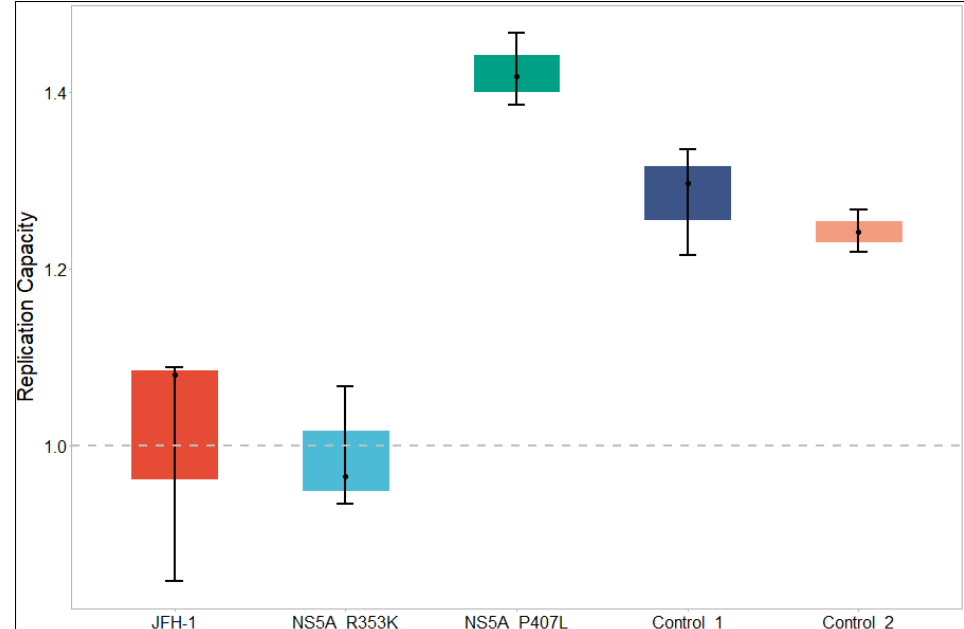
Figure 2. Replication capacities of JFH-1 (wildtype), SGR constructs harbouring polymorphisms unique to P19 and P20 (R353K and P407L), and controls. Control_1 harbours the polymorphisms F28S and L31I. Control_2 harbours the polymorphisms P29S and K30G.